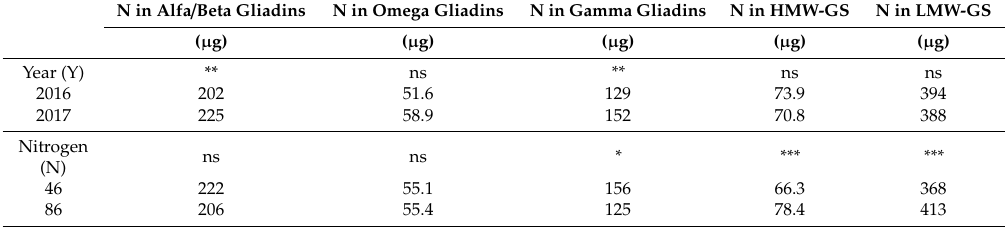
Table 4. Grain content of the gliadin groups (alfa / beta, omega, and gamma), and of the glutenin subunits (high- and low-molecular weight: HMW and LMW) ( µ g of N in each component). Results from Least Square Means and the analysis of variance